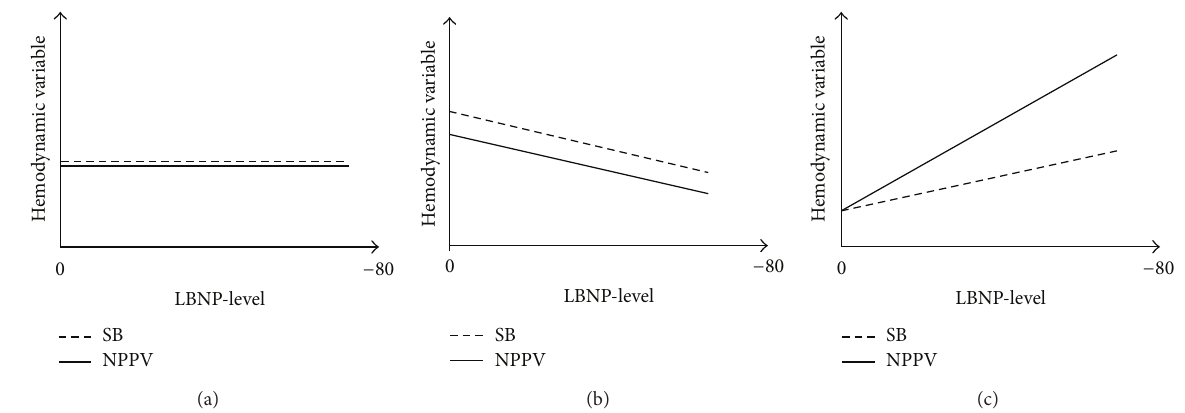
Figure 3: Illustration of different effects of LBNP and NPPV on hemodynamic variables. (a) No effect of LBNP or NPPV alone or in combination(forinstanceMAP),(b)independenteffectsofbothLBNPandNPPV(strokevolume),and(c)independenteffectofLBNPwhich increases in combination with NPPV (interaction; Δ PP). No effect of NPPV alone. LBNP: lower body negative pressure, NPPV: noninvasive positive pressure ventilation, SB: spontaneous breathing, MAP: mean arterial pressure, Δ PP: pulse pressure